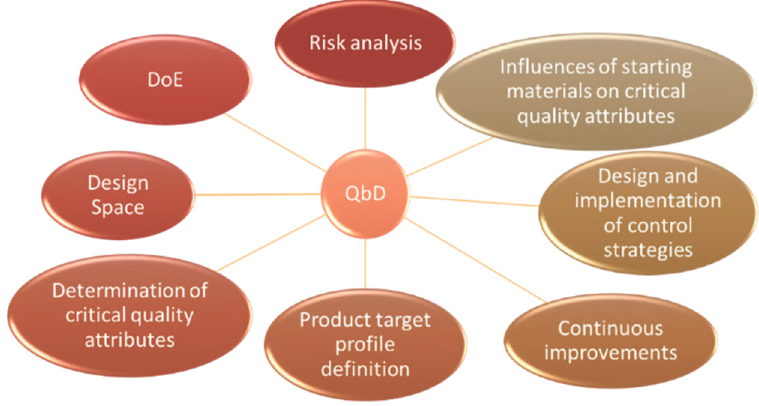
Figure 1. Illustrative summary of key elements of the quality by design study.